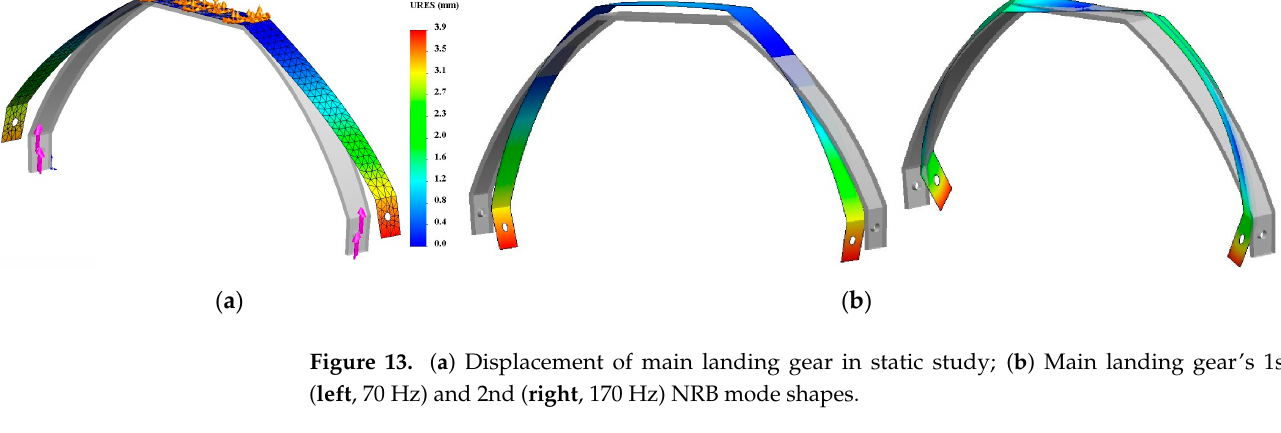
( c ) Figure 14. ( a ) Original part with applied manufacturing constraints, ( b ) Mass reduction plot from topology optimization study, ( c ) Optimized shape used in final model.